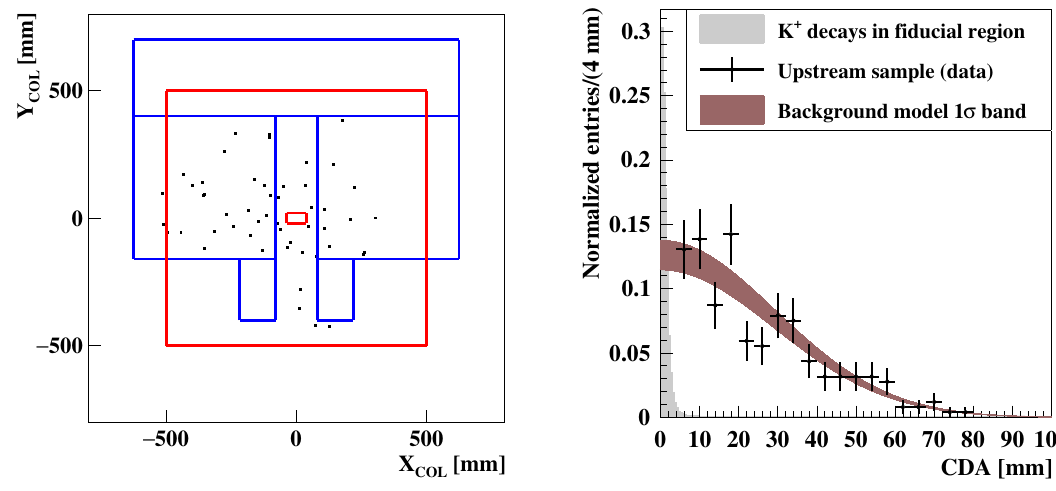
Figure 5 . Properties of upstream background events. Left: extrapolation of π + tracks of the upstream sample described in the text to the (X , Y ) plane in the S2 subset. The small COL COL (large) red rectangles correspond to the inner (outer) borders of the new collimator. The outline of the last dipole of the beam achromat is shown with blue solid lines. Right: CDA distribution of the events in the upstream sample shown on the left plot (black markers with error bars), compared to the CDA distribution extracted from data and its uncertainty (brown shaded area) and to the same distribution of K + decaying in the FV (grey shaded